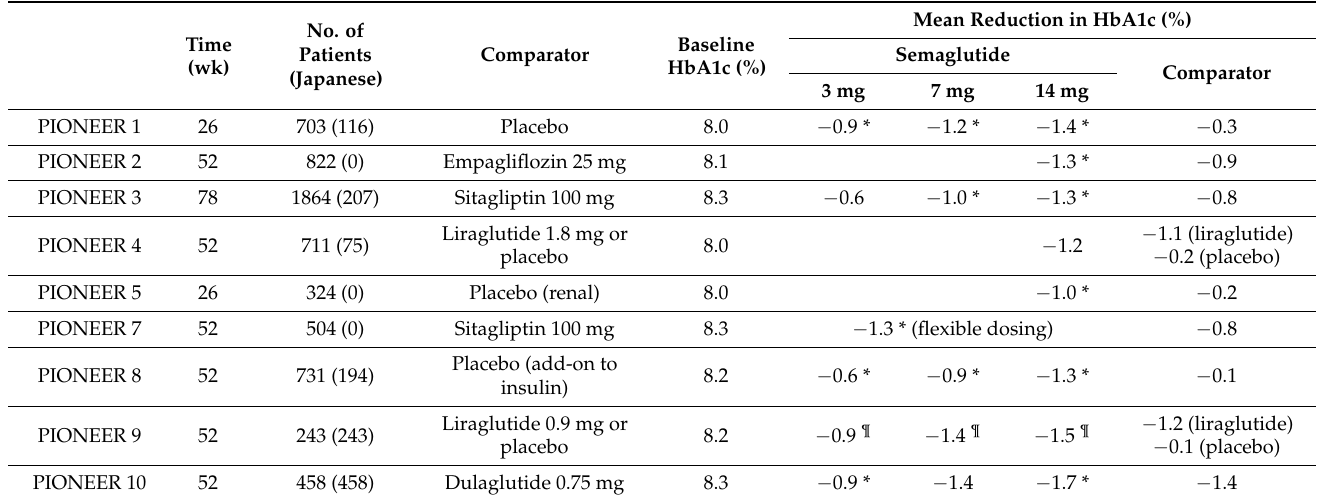
Table 1. Summary of efficacy in glycemic control across the PIONEER trials [43–51].